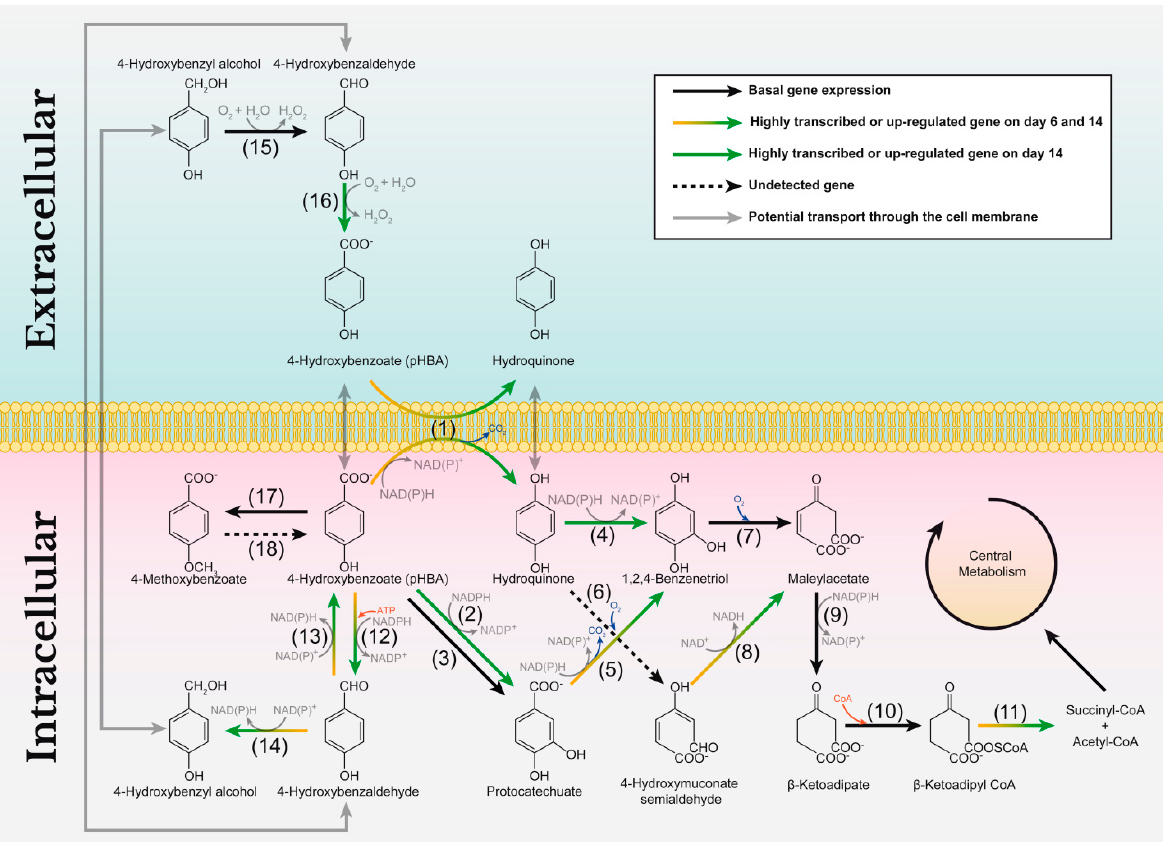
Figure 12. Proposed pathways for the conversion of pHBA by P. eryngii . Continuous arrows indicate enzymatic steps for which enzymes were found in the genome. The color codes indicate at least one of these enzymes expressed (from RNA-seq data) as described in the inset. Proposed enzymatic steps: (1) oxidative decarboxylase, (2) hydroxylase, (3) hydroxylation by P450s, (4) hydroxylase, (5) oxidative decarboxylase, (6) dioxygenase, (7) ring-cleaving dioxygenase, (8) 4-hydroxymuconic semialdehyde dehydrogenase, (9) maleylacetate reductase, (10) ketoacid-CoA transferase, (11) thiolase, (12) carboxylic acid reductase, (13) aldehyde dehydrogenase, (14) alcohol dehydrogenase, (15) alcohol oxidase, (16) aldehyde oxidase, (17) 4- O -methyl transferase and (18) demethylase (see Table S6 for additional information ) .